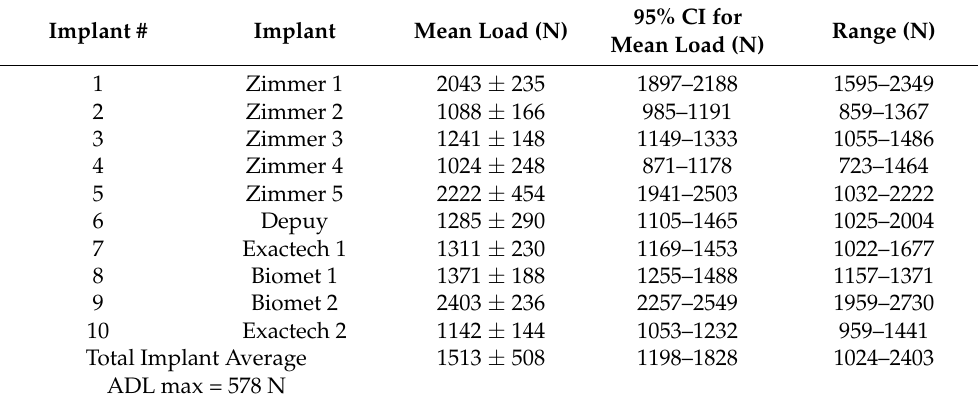
Table 1. Mean force to dissociation for each